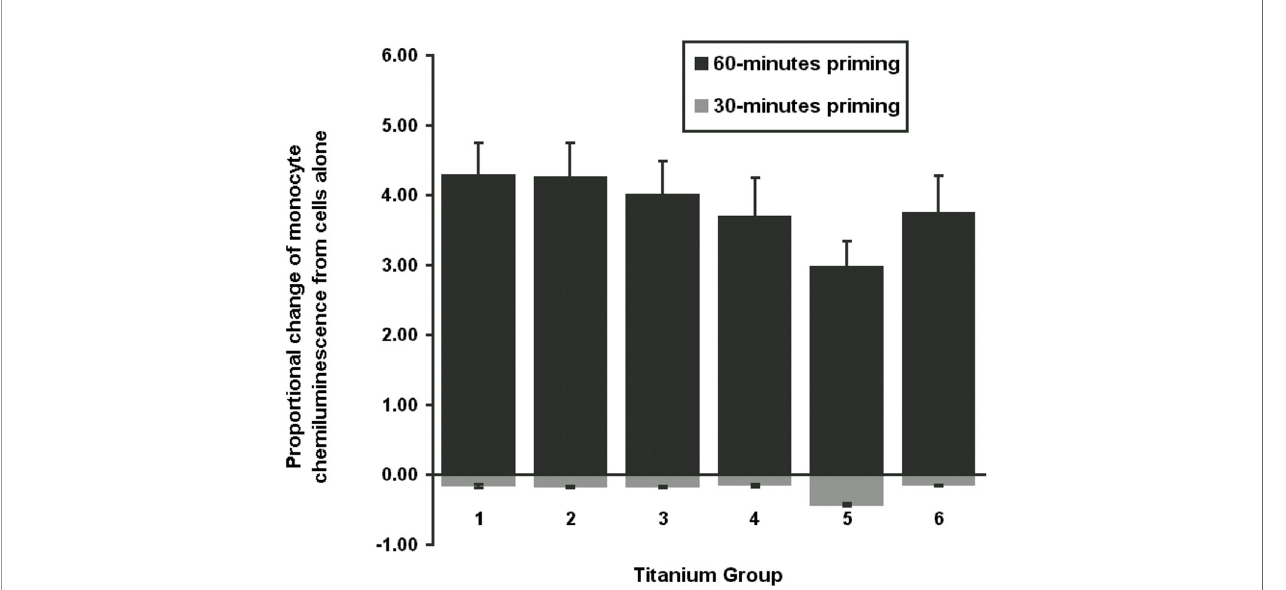
FIGURE 2 | Total chemiluminescence. Figure demonstrates the proportional change of mean monocyte chemiluminescence from cells only for 30-min or 60-min priming phase. Monocyte activation was with PMA stimulation at 10 -5 M with luminol 10 -6 M. CPT group 5 was signi fi cantly different to the other groups (P